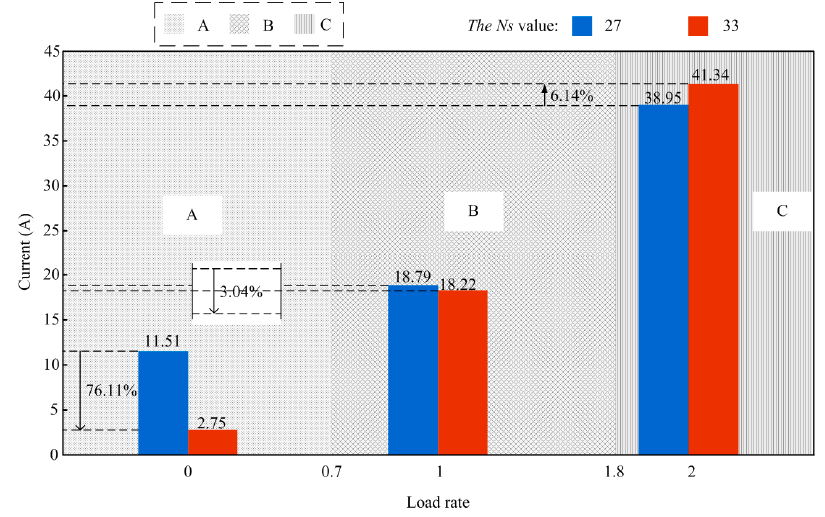
Figure 9. The current difference between N S being 27 and 33 under three different states.